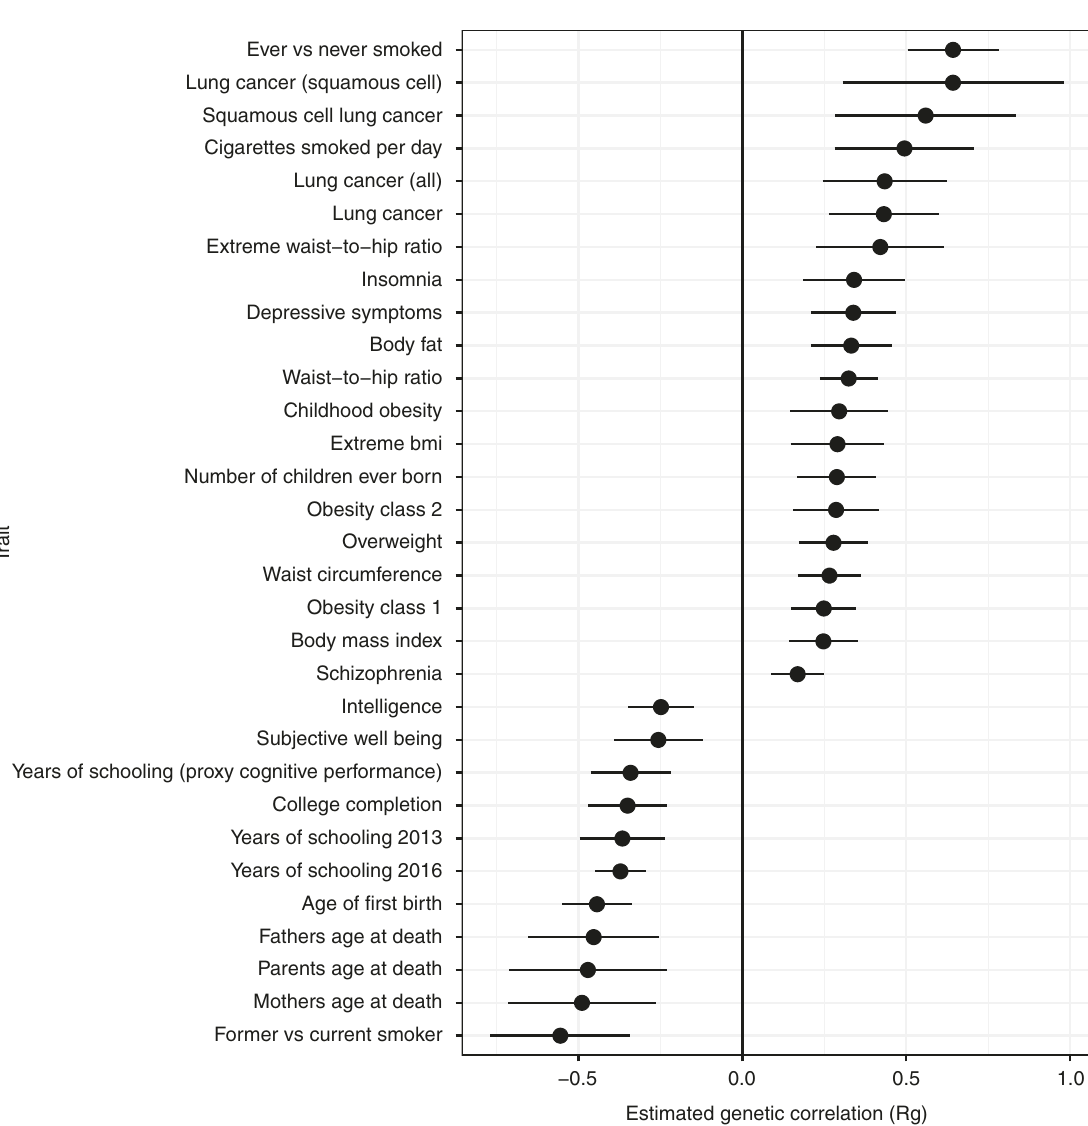
Fig. 4 Estimated genetic correlations between periodontitis/loose teeth and health traits or outcomes. Markers indicate the estimated magnitude of R g , error bars represent 95% con fi dence intervals (1.96* LDSR standard errors on either side of the point estimate) Table 3 Estimated causal effect of a one standard deviation greater lifetime burden of dental disease as measured by DMFS Trait Untransformed beta